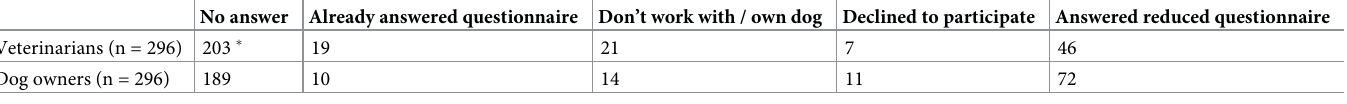
Table 2. Telephone calls to random representatives of target populations. These were performed for qualitative assessment of non-responders, as part of the non- response analysis. No answer Already answered questionnaire Don’t work with / own dog Declined to participate Answered reduced questionnaire Veterinarians (n = 296) 203